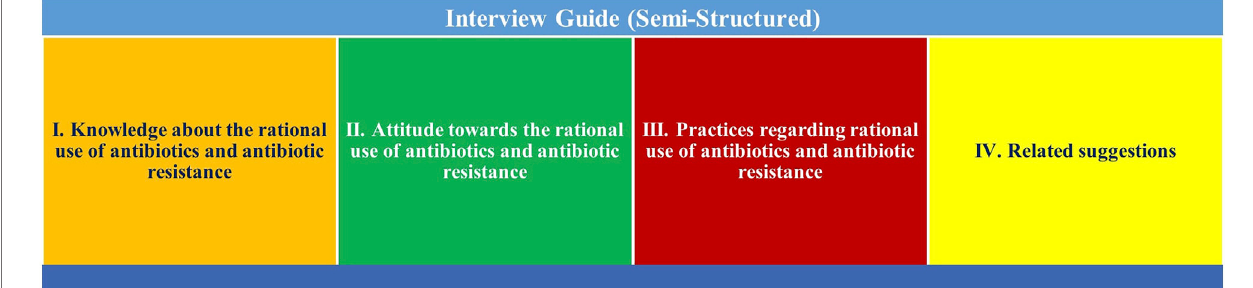
Frontiers in Pharmacology |